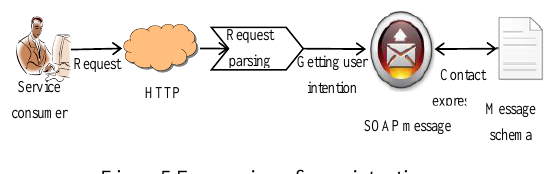
Figure5.Expression of user intention